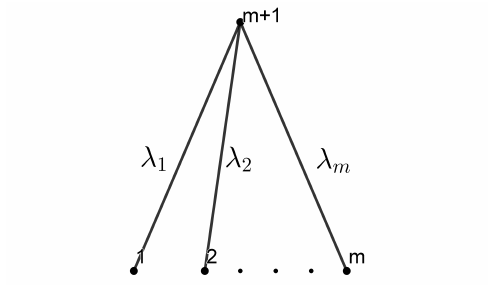
Figure 5. Hypersurface M m